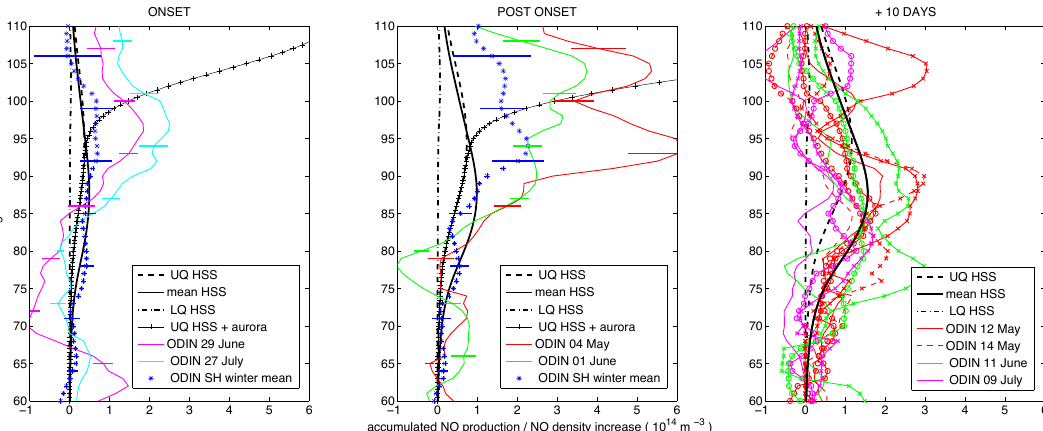
Figure 7. Comparison of modelled NO production with Odin-SMR observations of NO number density increase during HSS. Model profiles, corresponding to the different models of incoming energetic electron fluxes listed in Table 1, are shown in black for NO total production during 1 day (left-hand panel labelled “ONSET”), 2 days (middle panel labelled “POST-ONSET”), and 10 days (with steadily decreasing flux, right-hand panel labelled “ + 10 DAYS”). “Aurora” fluxes are applied for only 4h each day, and HSS fluxes for the whole day. Observations are the differences between pre-onset, onset and post-onset observations for four HSS events shown in Fig. 6 (solid lines) and for the average of all Southern Hemisphere wintertime HSS events covered by Odin-SMR measurements during the years 2007–2014 ( ∗ ). All observations are based on zonal averages over UT days and 5 ◦ bands of geomagnetic latitude. Left and centre panels for geomagnetic latitude 60–65 ◦ S, and right panel for geomagnetic latitudes 60–65 ◦ S (no marks along line), 70–75 ◦ S (circles) and 80–85 ◦ S